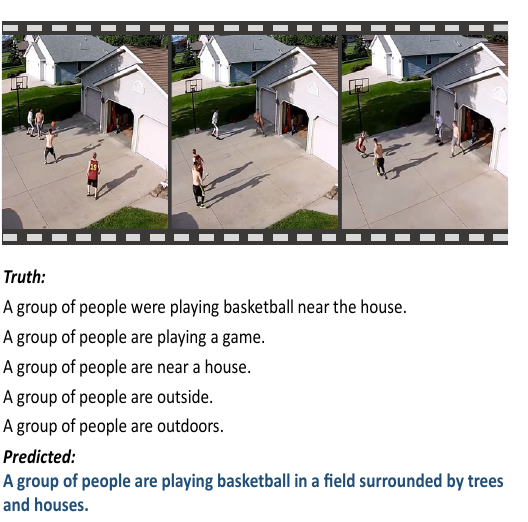
Figure 6. Visualization of some generated captions by the second proposed model. The black-color texts indicate the five ground-truth captions, while the blue-color texts indicate the generated cap- tion.